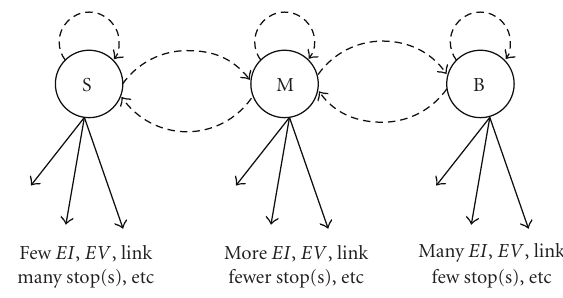
Figure 5: A hidden Markov model.